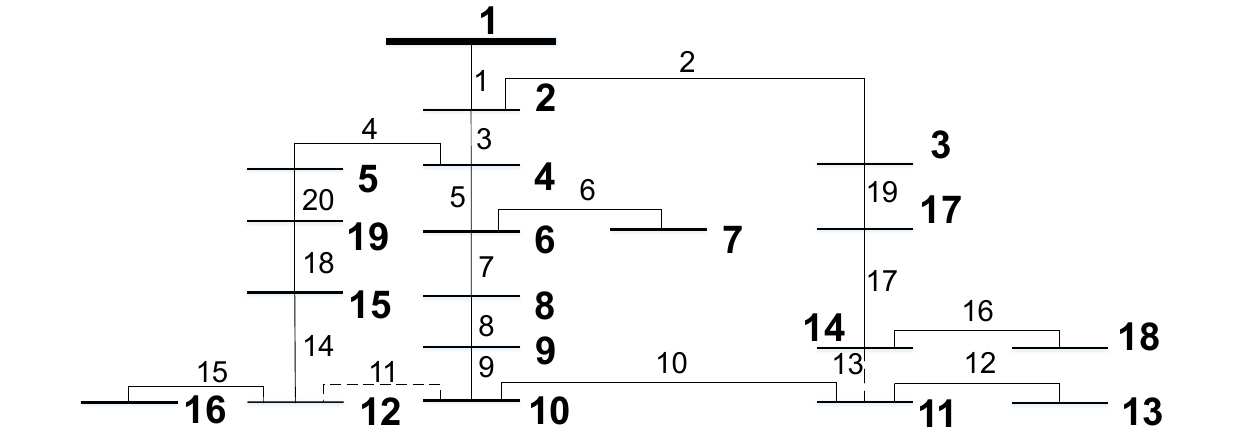
Figure 12. 19-bus and 20-branch system final configuration (variable). Table 12. Results found for the 25-bus and 27-branch unbalanced system (fixed demand).